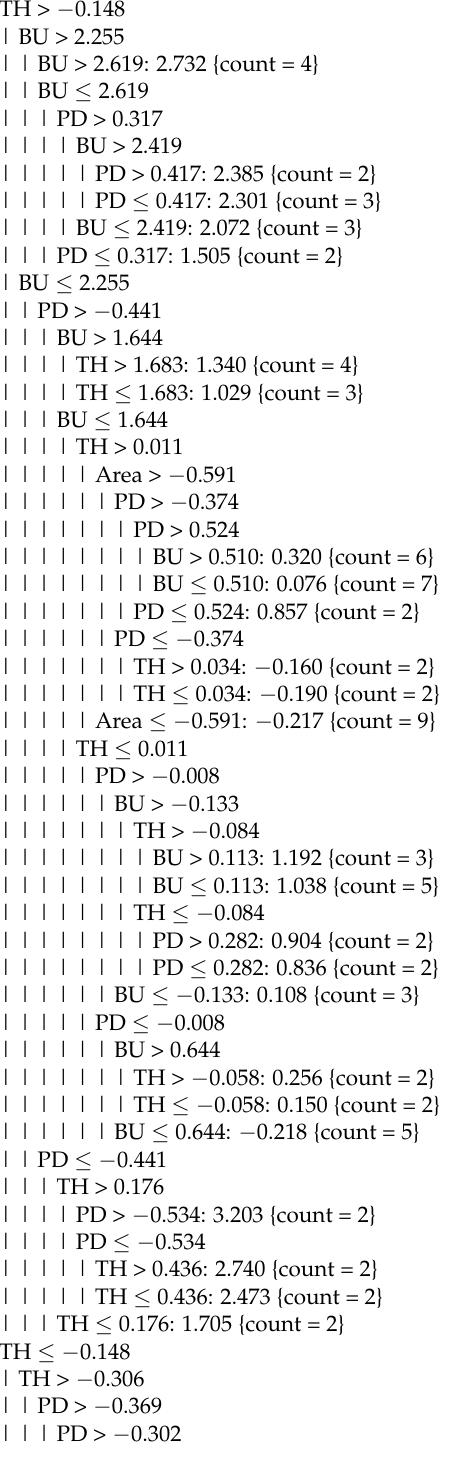
Table A1. The description of the Regression Tree Model (Decision